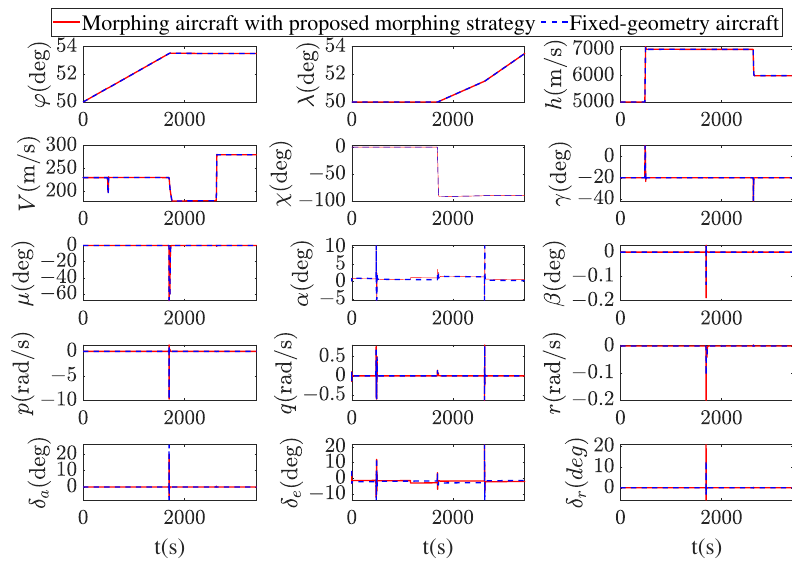
Figure 16. The states and rudder sufaces of the comparative simulation in Section 5.1.